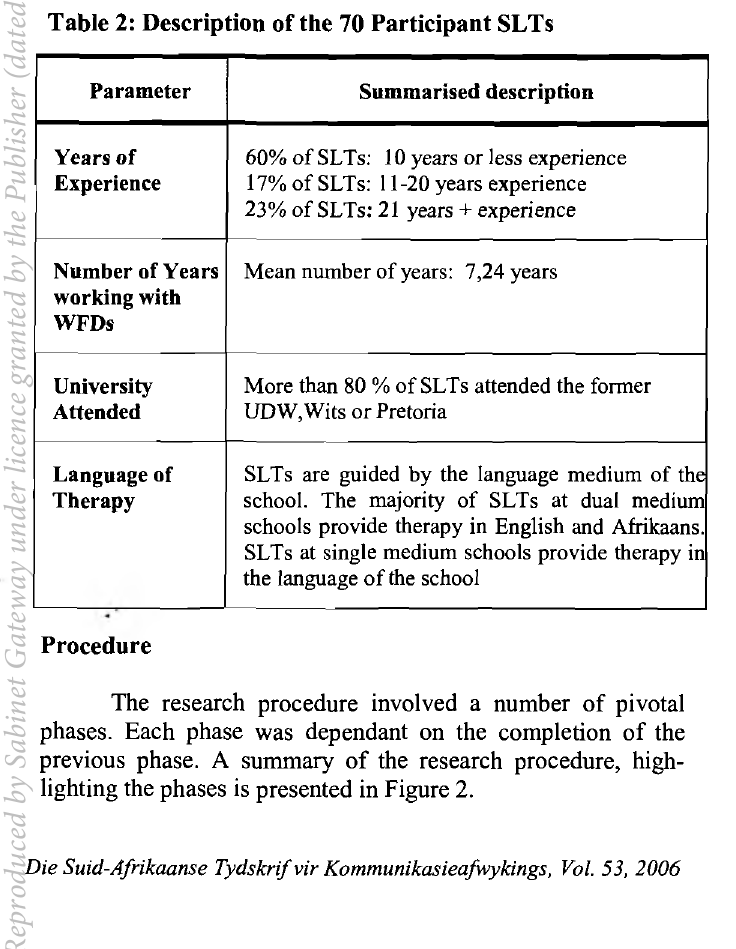
Table 2: Description of the 70 Participant SLTs